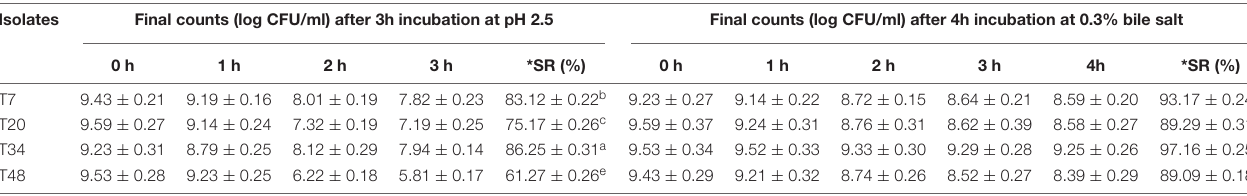
TABLE 3 | Re-screening results and survival rates (%) of isolated LAB after 3 h incubation at pH 2.5 and 4 h incubation at 0.3% bile salt. Isolates Final counts (log CFU/ml) after 3h incubation at pH